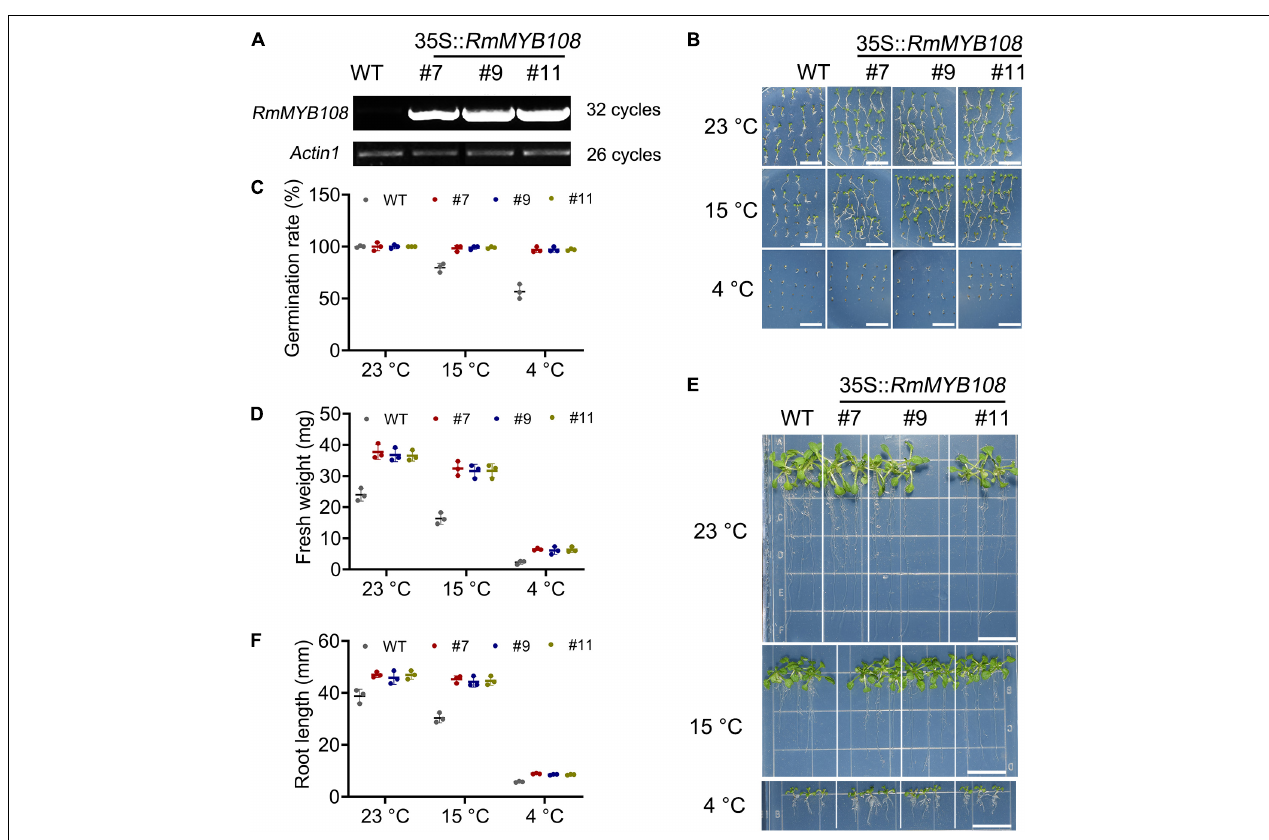
FIGURE 4 | Identification of RmMYB108 -overexpressing Arabidopsis and cold tolerance contrast between wild type (WT) and #7, #9, and #11 OE lines at early growth stage of plants. (A) semiquantitative RT-PCR analysis of RmMYB108 and Actin1 in WT and overexpression (OE) lines showed the overexpression of RmMYB108 in transgenic plants. The 7-days seed germination phenotype (B) , seed germination rate (C) , 21-day seedlings fresh weight (D) , growth (E) , and root length (F) of WT and OE lines under 23, 15, and 4 ◦ C, respectively, indicated OE lines had higher cold tolerance than WT. Data represent mean value + SD ( n = 30). * p < 0.05; ** p < 0.01; *** p < 0.001 in